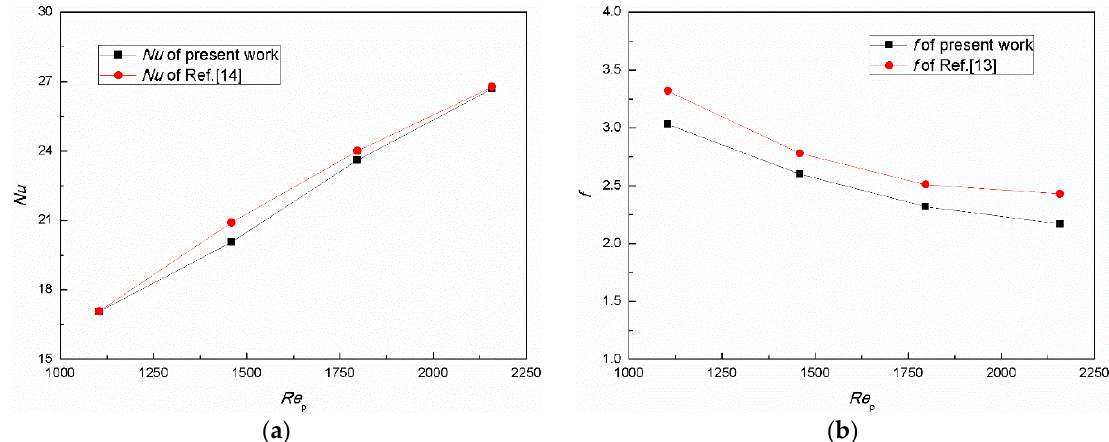
Figure 2. Comparisons of ( a ) Nu and ( b ) f between the numerical and experimental results.